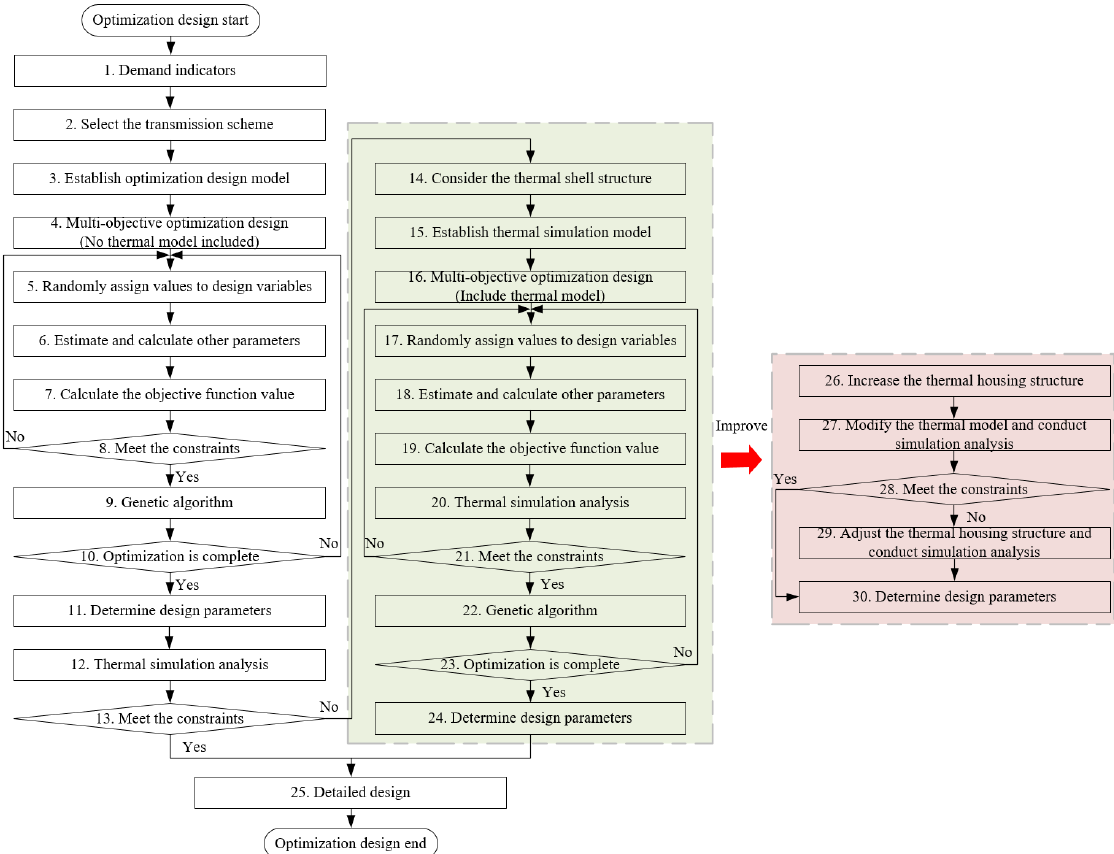
Figure 8. Flow chart of IEMM performance optimization design.